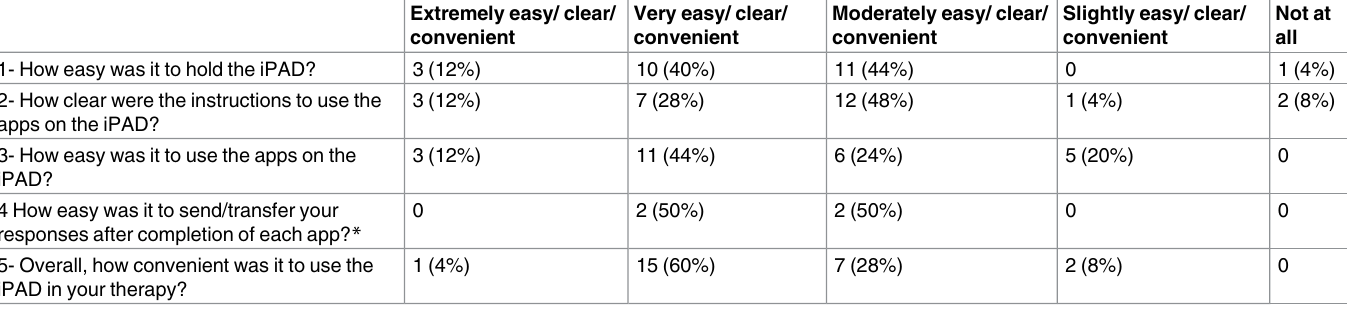
Table 3. Responses to iPad convenience survey (n =